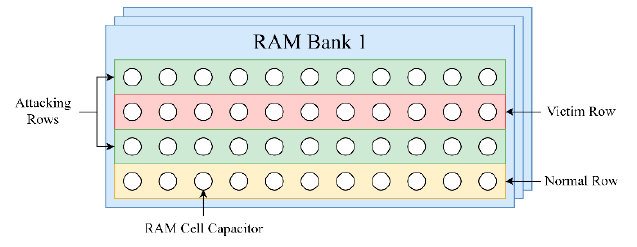
Figure 15. RowHammer